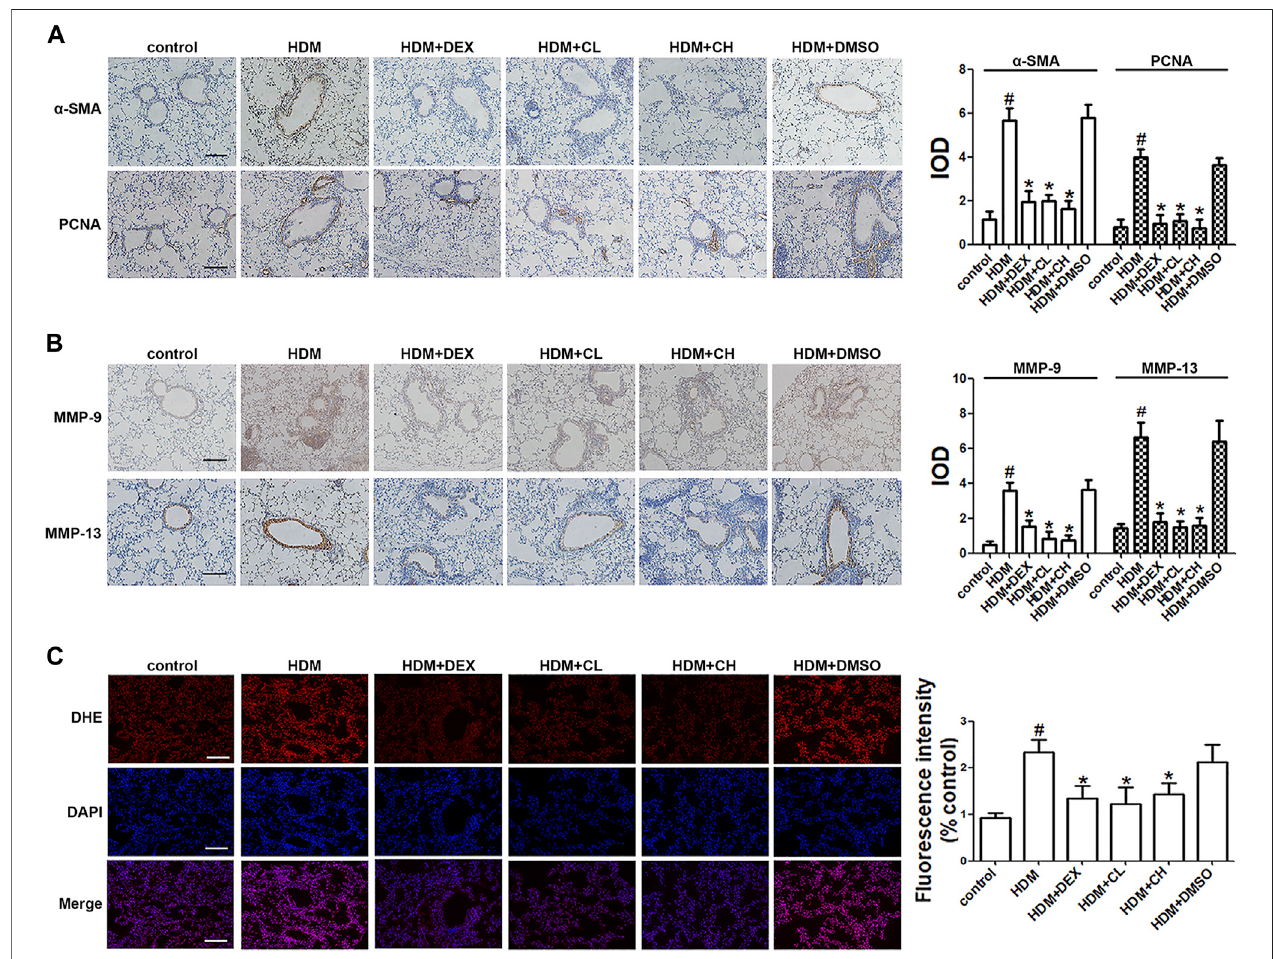
FIGURE 2 | Treatment with chloroquine inhibited the expression of α -SMA, PCNA, MMP-9, MMP-13, and in situ ROS levels in lung tissue (A,B) Immunohistochemical staining was performed to assess the distribution of α -SMA, PCNA, MMP-9, and MMP-13 (magni fi cation, ×400; scale bar, 50 µm), and their expression was evaluated, respectively. The staining scores were multiplied by the percentage of positive epithelial cells and staining intensity scores (C) Frozen lung sections werestainedwithDHE,imagedand analyzed byImage-ProPlus6.0. The fl uorescence valueswereexpressed astheratiotothelevelsinthecontrolcells. Values are the mean ± SEM ( n = 6 per group). # p < 0.05 compared with the control group, and * p < 0.05 compared with the HDM